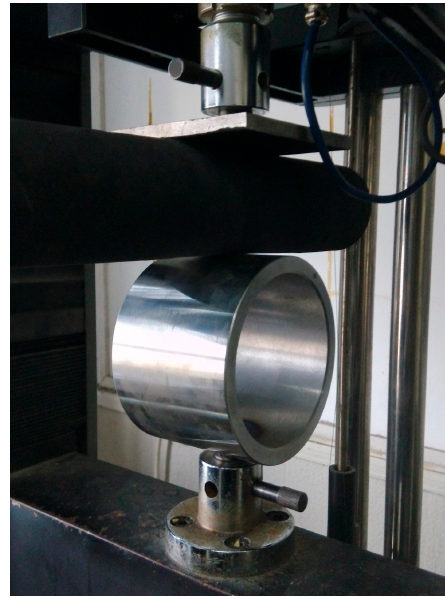
Figure 7. Set up of the counter force test.